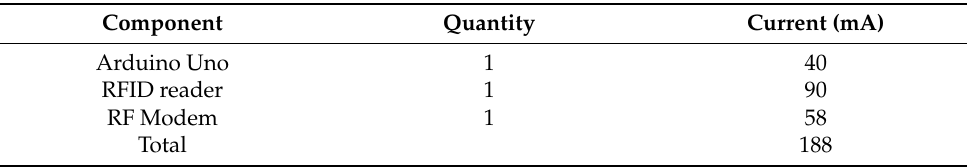
Table 7. Current consumption analysis of the two-wheeler